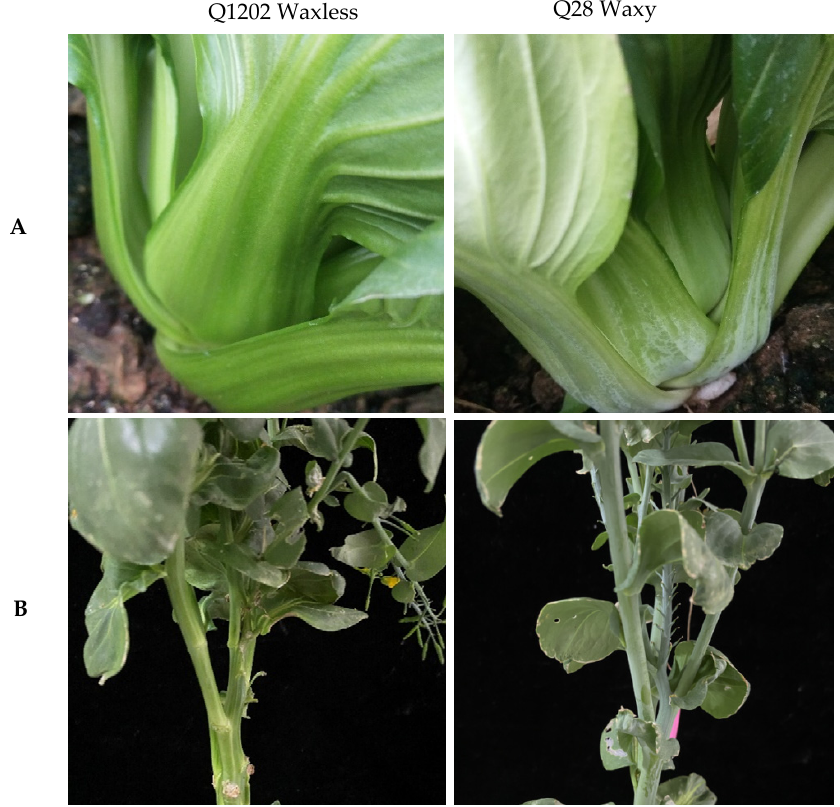
Figure 1. Phenotypes of Q1202 and Q28 at rosette ( A ) and shoot stages( B